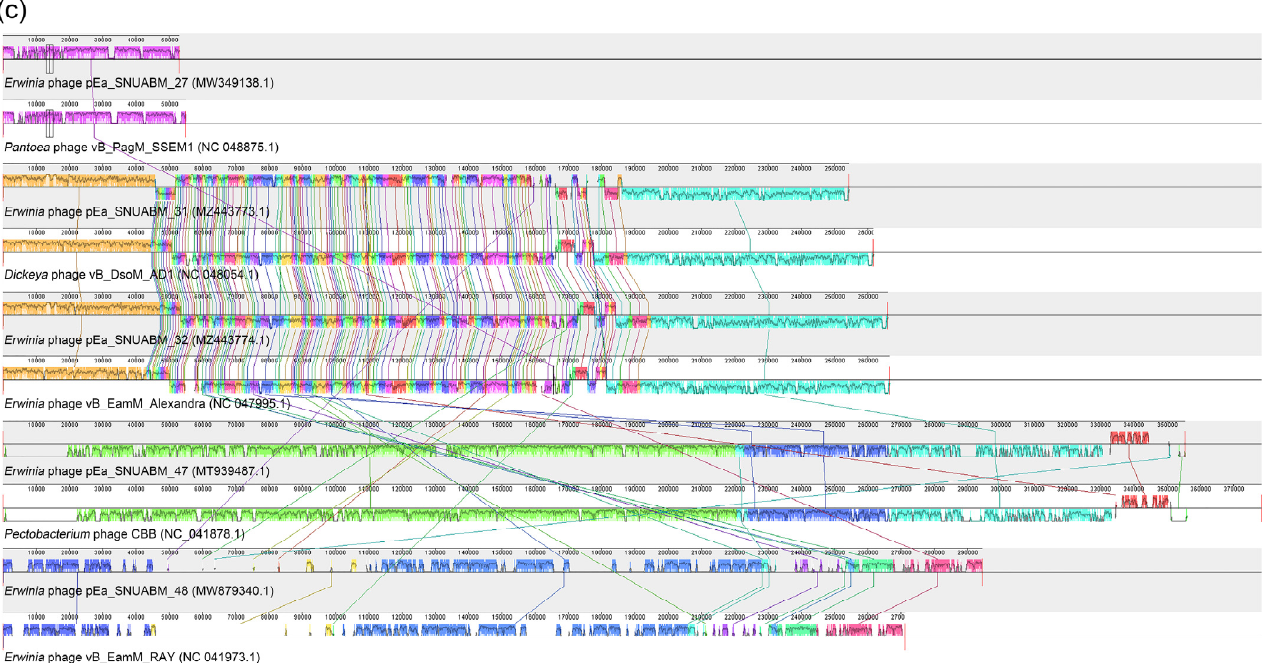
Figure 7. Phylogenetic whole genome analysis of 79 phages infecting Erwinia spp., Dickeya spp., Pantoea spp., and Pectobacterium spp. ( a ) The phylogenetic tree was constructed using Virus Clas- sification and Tree Building Online Resource (VICTOR). Black arrows ( ▶ ) indicate the five Erwinia phages in this study. Black letters next to genus indicate family of the phages (A: Ackermannviridae , M: Myoviridae , C: Chaseviridae , S: Schitoviridae , D: Drexlerviridae , Au: Autographiviridae ). The genus of ϕ 27 was identified as Loessnervirus , that of ϕ 31 and ϕ 32 as Alexandravirus , that of ϕ 47 as Eneladusvirus , while that of ϕ 48 was unclassified. ( b ) Dot plot analysis of the 79 phages with parallel order of phylogeny. ( c ) Comparative whole genome analysis using progressive Mauve.